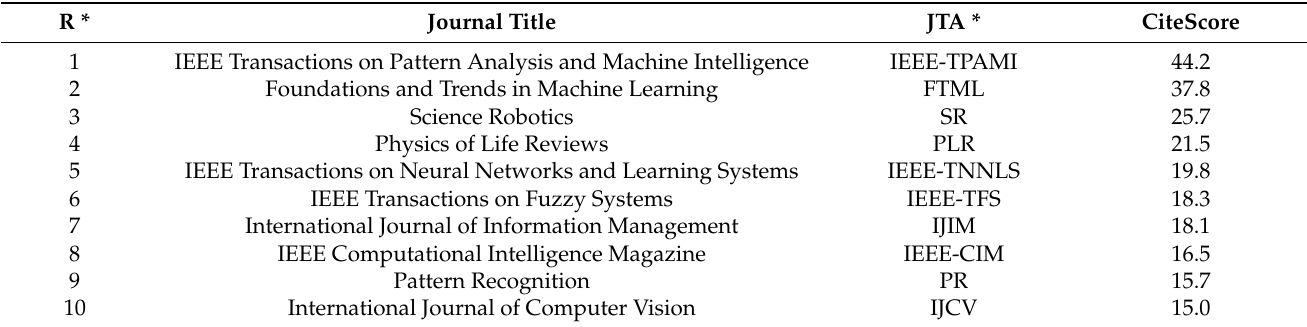
Table 1. The leading AI academic journals based on